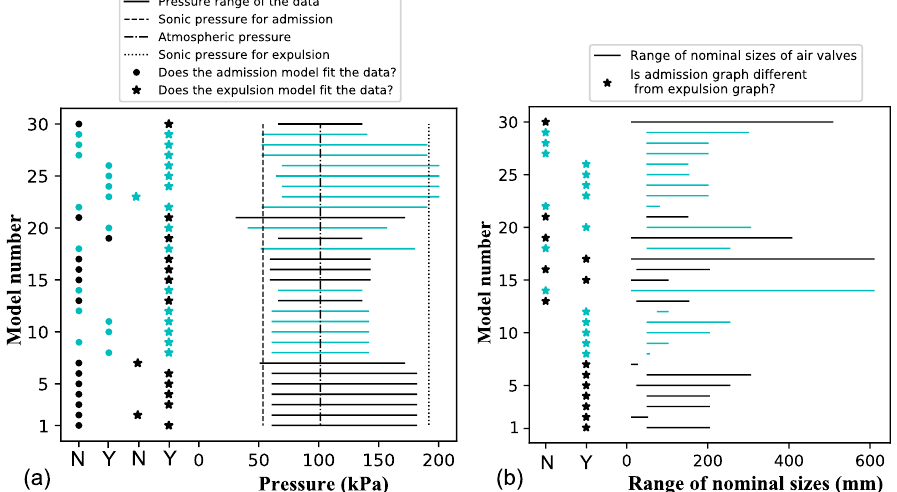
Figure 2. Consistency evaluation of CCs found in product catalogs: ( a ) Whether the isentropic air flow model can be fitted to the admission and expulsion data (on the left ), pressure ranges of the CCs (on the right ); ( b ) whether the graphs for admission and expulsion are equivalent or different (on the left ), range of nominal sizes of the air valve models (on the right